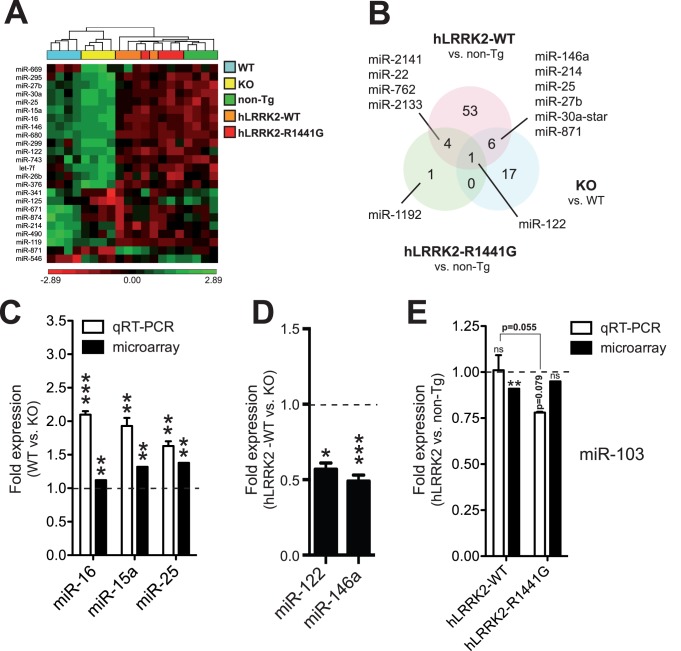
miRNA microarray analysis of LRRK2 mice.(A) Cluster analysis of significantly (FDR<0.2) misregulated mature miRNAs in various LRRK2 mouse models. Results were generated using Partek Genomics Suite. (B) Venn diagram showing variable overlap between significantly (FDR<0.2) misregulated miRNAs in LRRK2 mice. (C, D and E) Validation of miRNAs by real-time qRT-PCR, as indicated. Statistical significance was determined by a Student unpaired t test (* = p<0.05, ** = p<0.01, *** = p<0.001). Standard error of the mean (SEM) is shown.